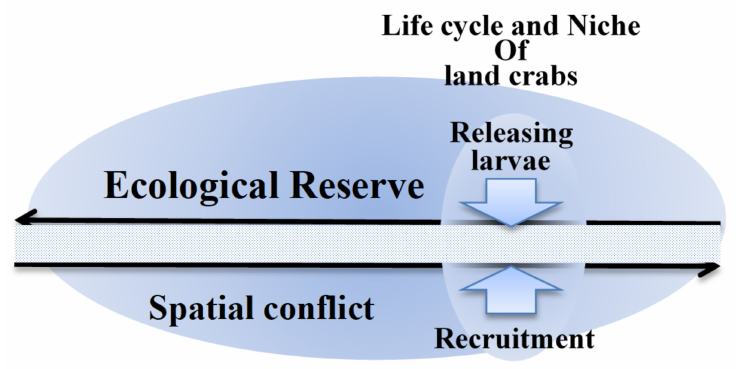
Figure 1. Concept of spatial conflict in Banana Bay